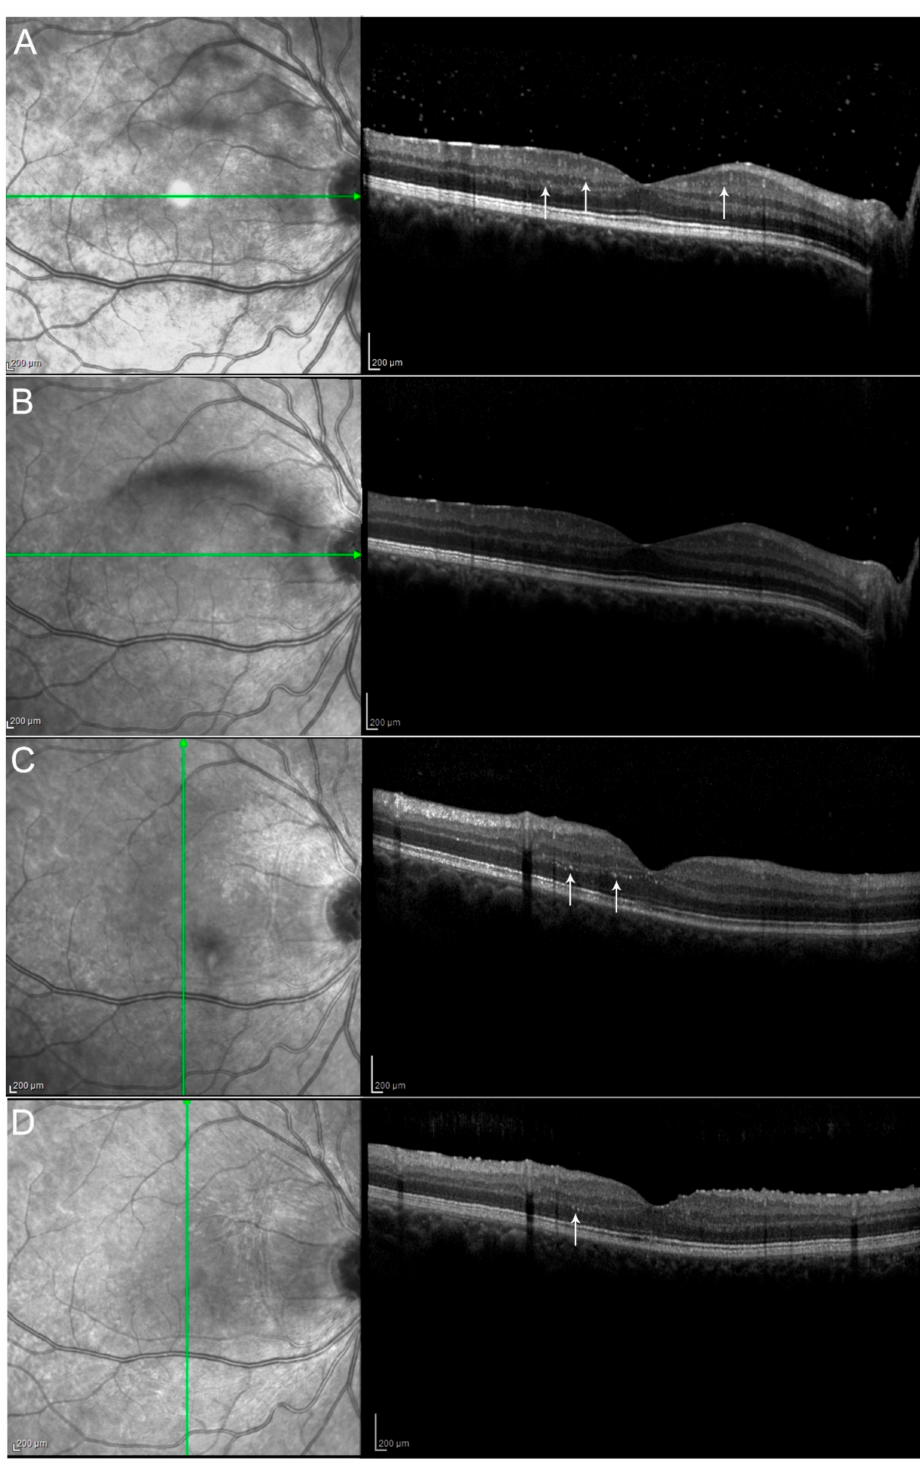
Figure 4. Hyperreflective retinal spots (see arrows ) and vitritis shown at baseline ( A ) decreased one month after the beginning of the therapy with Adalimumab ( B – D ) show the same patient at M3 and M6 respectively with further improvement, although without complete disappearance of the spots. Hyperreflective spots have already been described as aggregates of activated microglial cells and could be considered a marker of neuroinflammatory response in the retina. They may also reflect retinal microvascular changes that occur in uveitic